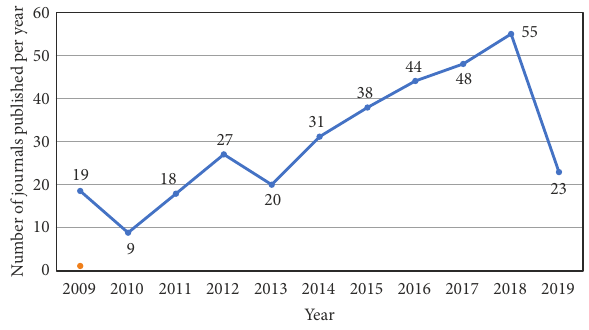
Figure 2. The trend of number of published papers per year from year 2009 to 2019